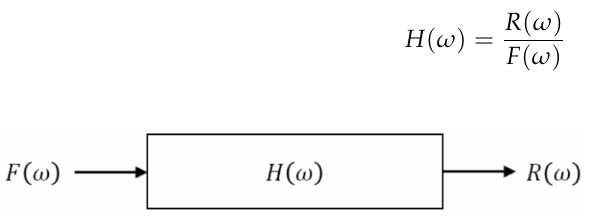
Figure 1. Relationship between input impulse and output response in normal system.